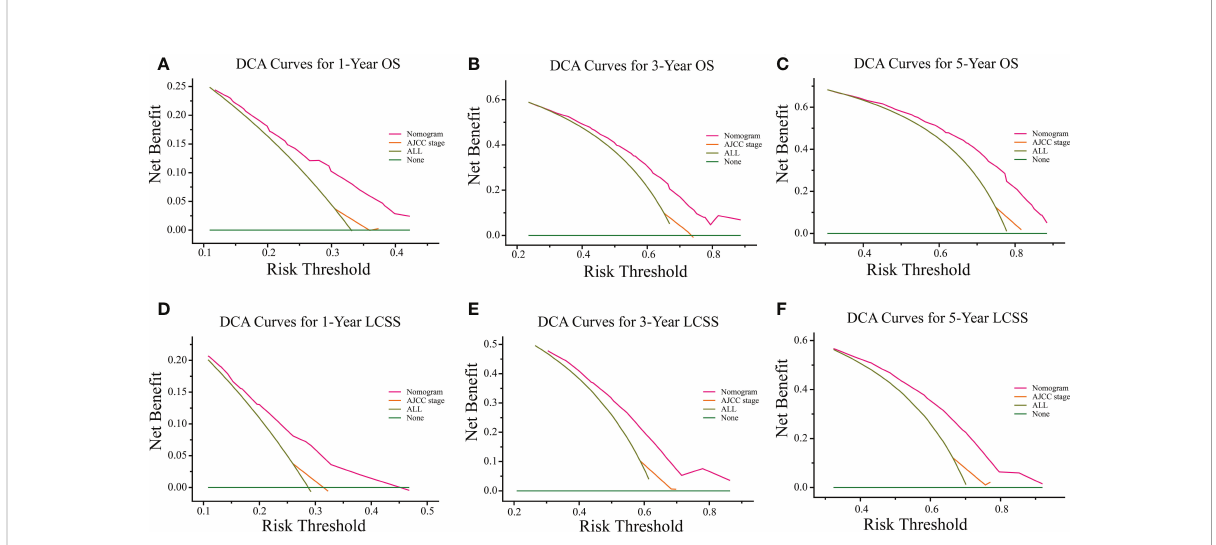
FIGURE 7 DCA curves of the proposed nomogram and 8th edition AJCC TNM staging system for 1-, 3-, and 5-year OS (A – C) and LCSS (D – F) . The x-axis represents the risk threshold, and the y-axis measures the net bene fi t. The green horizontal solid line along the x-axis assumes that overall death occurred in no patients, whereas the light green solid line assumes that all patients will have overall death at a speci fi c threshold probability. The pink solid line represents the nomogram. The orange solid line represents the 8th edition AJCC TNM staging system. DCA,